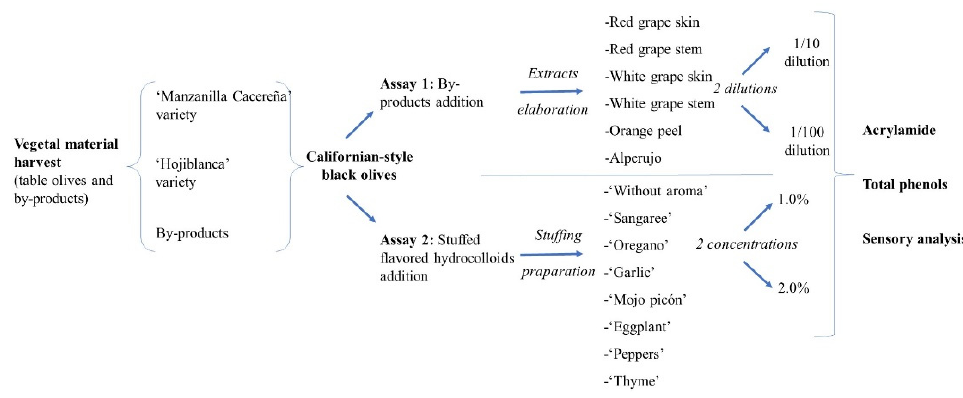
Figure 1. Diagram of the experimental design.